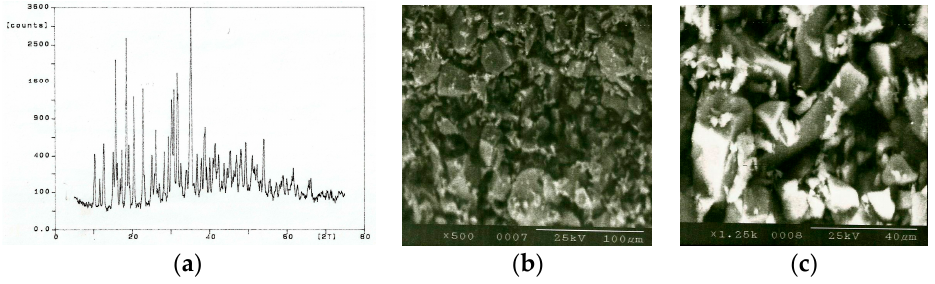
Figure 5. Borax frit (BX) material sample: ( a ) X-ray diffraction pattern for 2 θ angles showing arbitrary counts (counts) versus 2 θ angles (2T) in degrees; ( b ) Scanning electron micrograph at 500× magnification; and ( c ) Scanning electron micrograph at 1250× magnification.